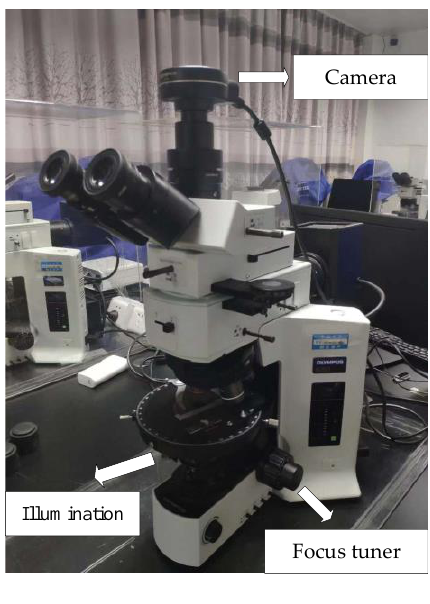
Figure 6. Microscope.